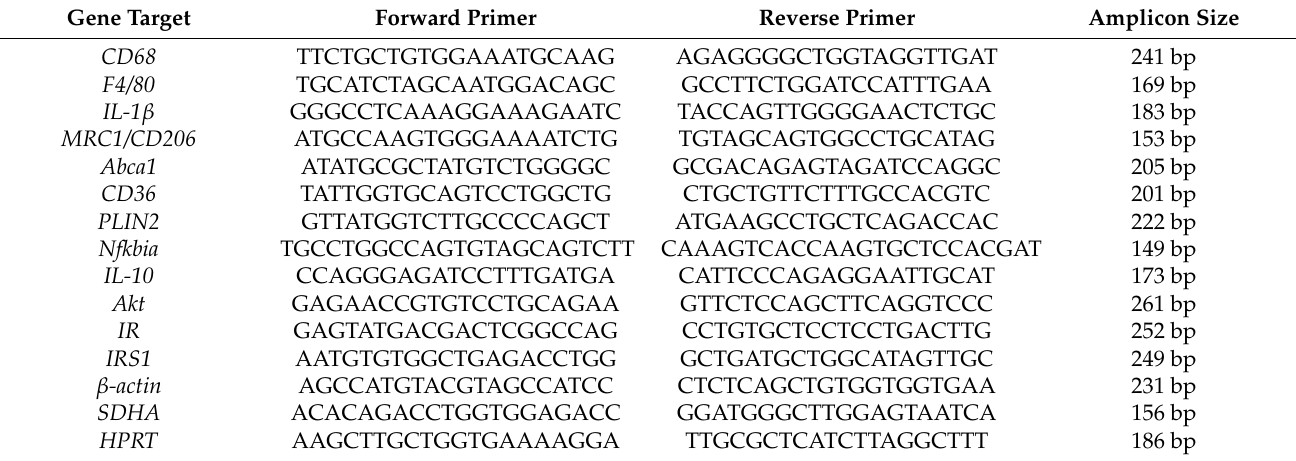
Table 1. Primer sequences used in PCR analyses.